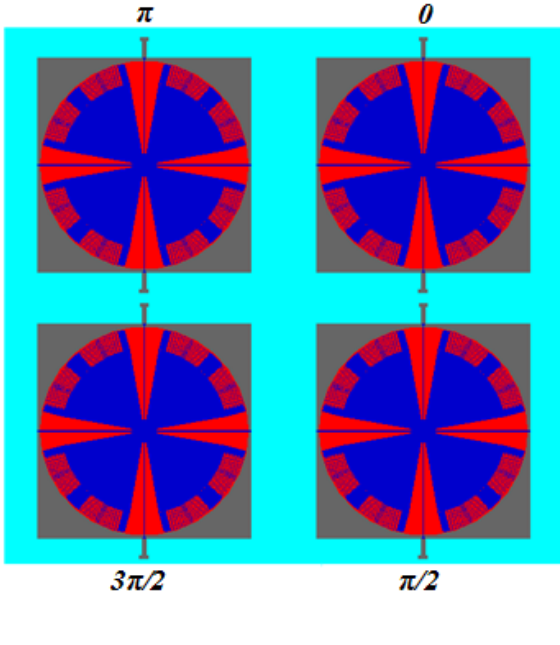
Figure 10. The array configuration with four MCMGs as an